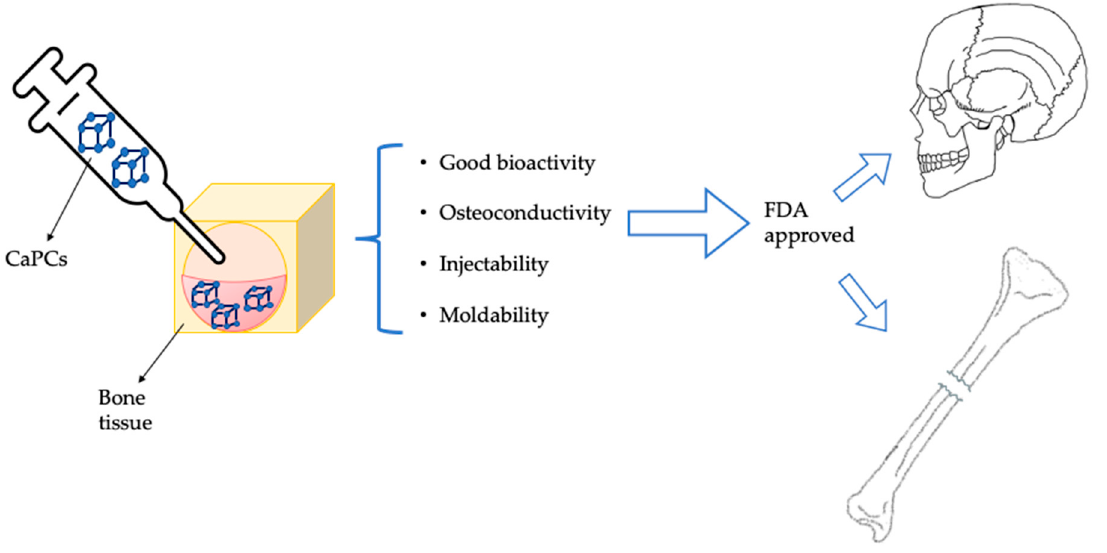
Figure 5. Schematic representation of the advantageous characteristics of bone injected calcium phosphate cements (CaPCs).